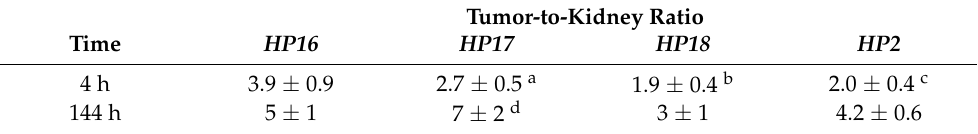
Table 6. Comparison of tumor-to-kidney ratios of new 177 Lu-labeled secondary probes in BALB/C nu/nu mice bearing SKOV3 xenografts at 4 and 144 h after injection. Primary agents (Z HER2:342 - SR- HP1 and Z HER2:342 -SR- HP15 , 50 µ g) were injected 16 h prior to 177 Lu-labeled-secondary probe injection. The uptake is expressed as % ID/g and presented as an average value from 5 mice ± SD. One-way ANOVA with Bonferroni’s multiple comparisons test was performed to find significant